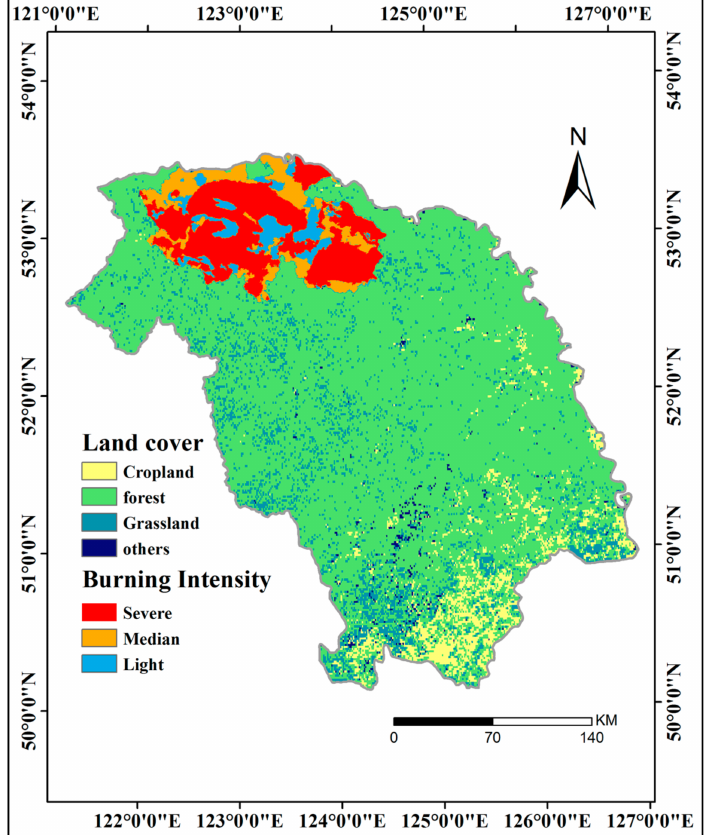
Figure 15. Burnt zone of the fire in 1987 and land cover in the